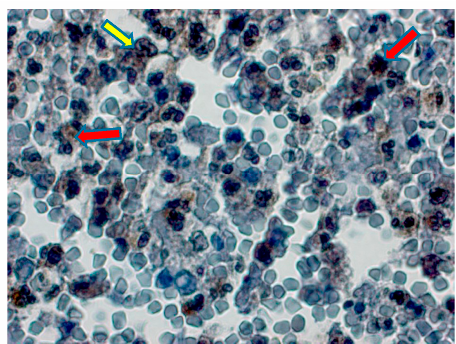
Figure 1. Type 2 diabetic group, separation of chromatin bridges in nuclei of granular leukocyte cells (yellow arrow), degenerative changes and apoptosis in some lymphocyte and neutrophils